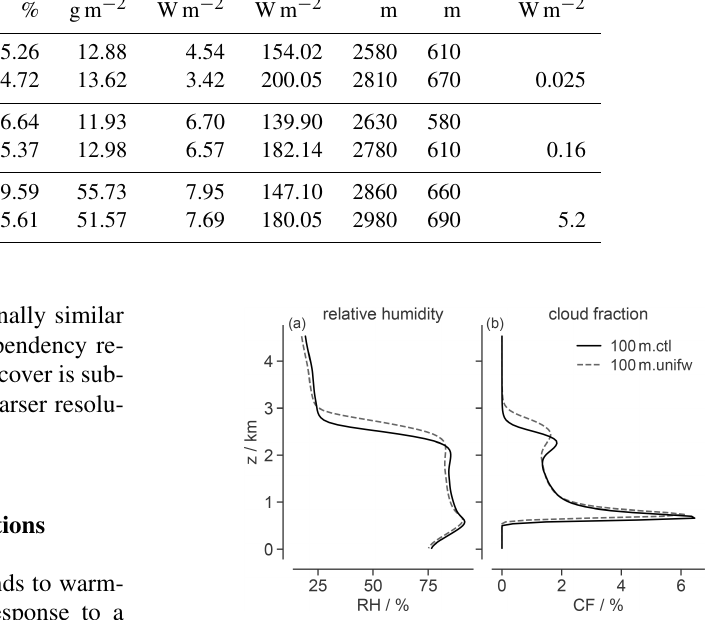
Table 3. As in Table 2 but for the precipitating simulations (P) of the ctl and unifw climate states. Case